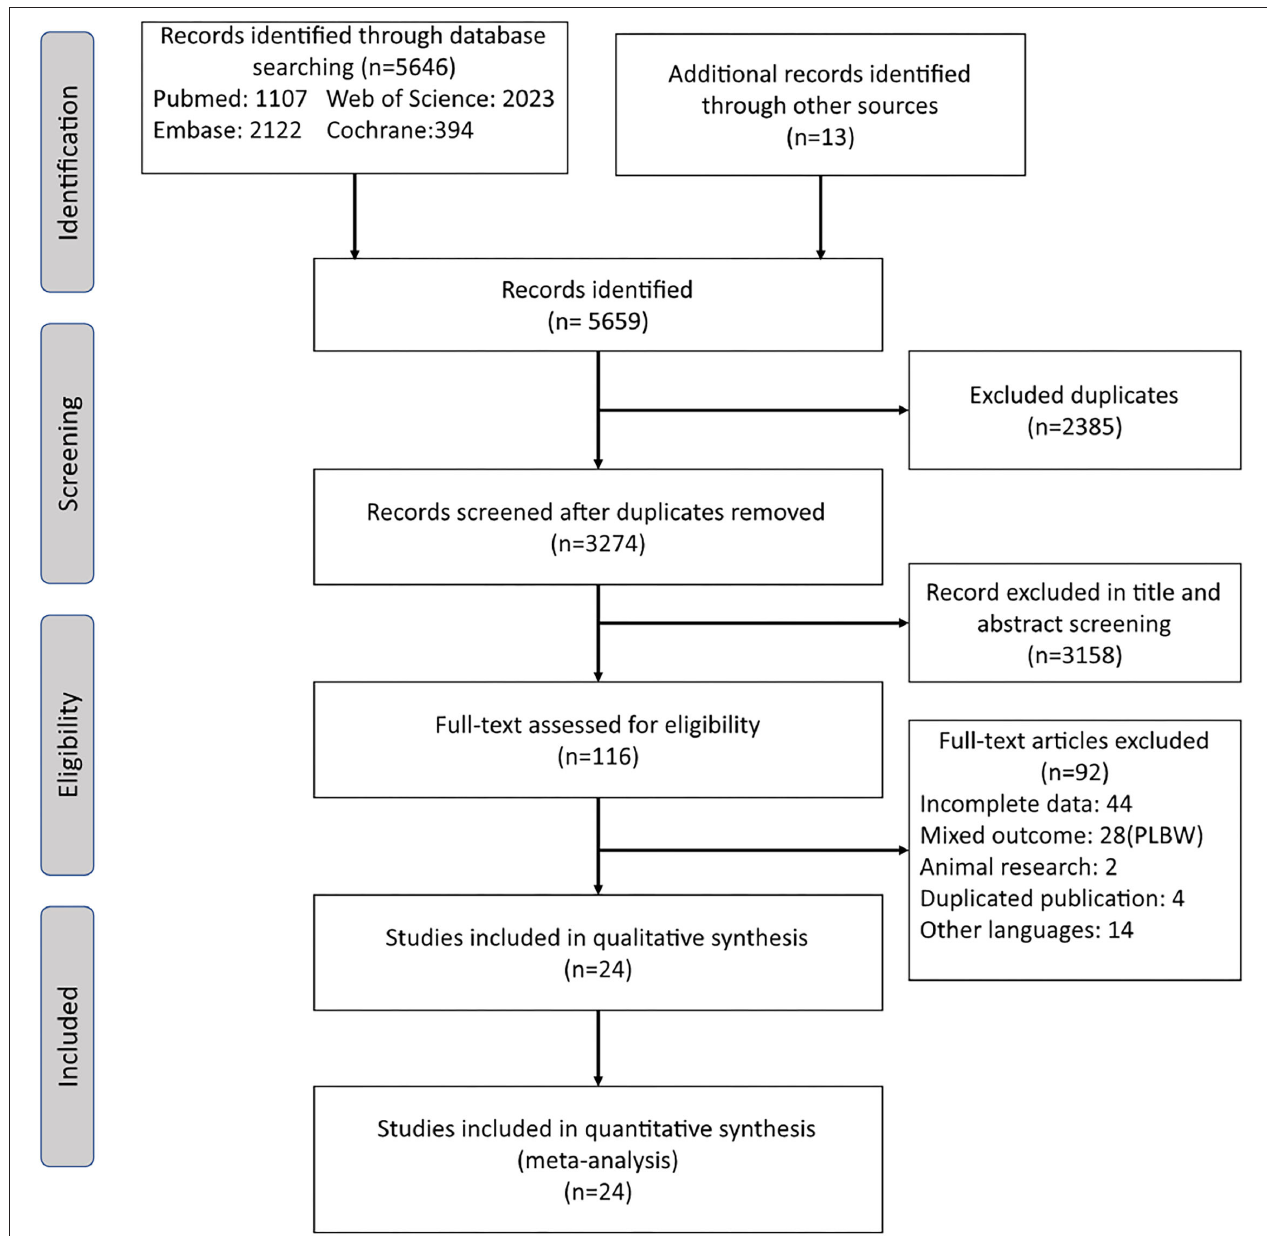
FIGURE 1 | Flowchart of the study selection process for the present meta-analysis.